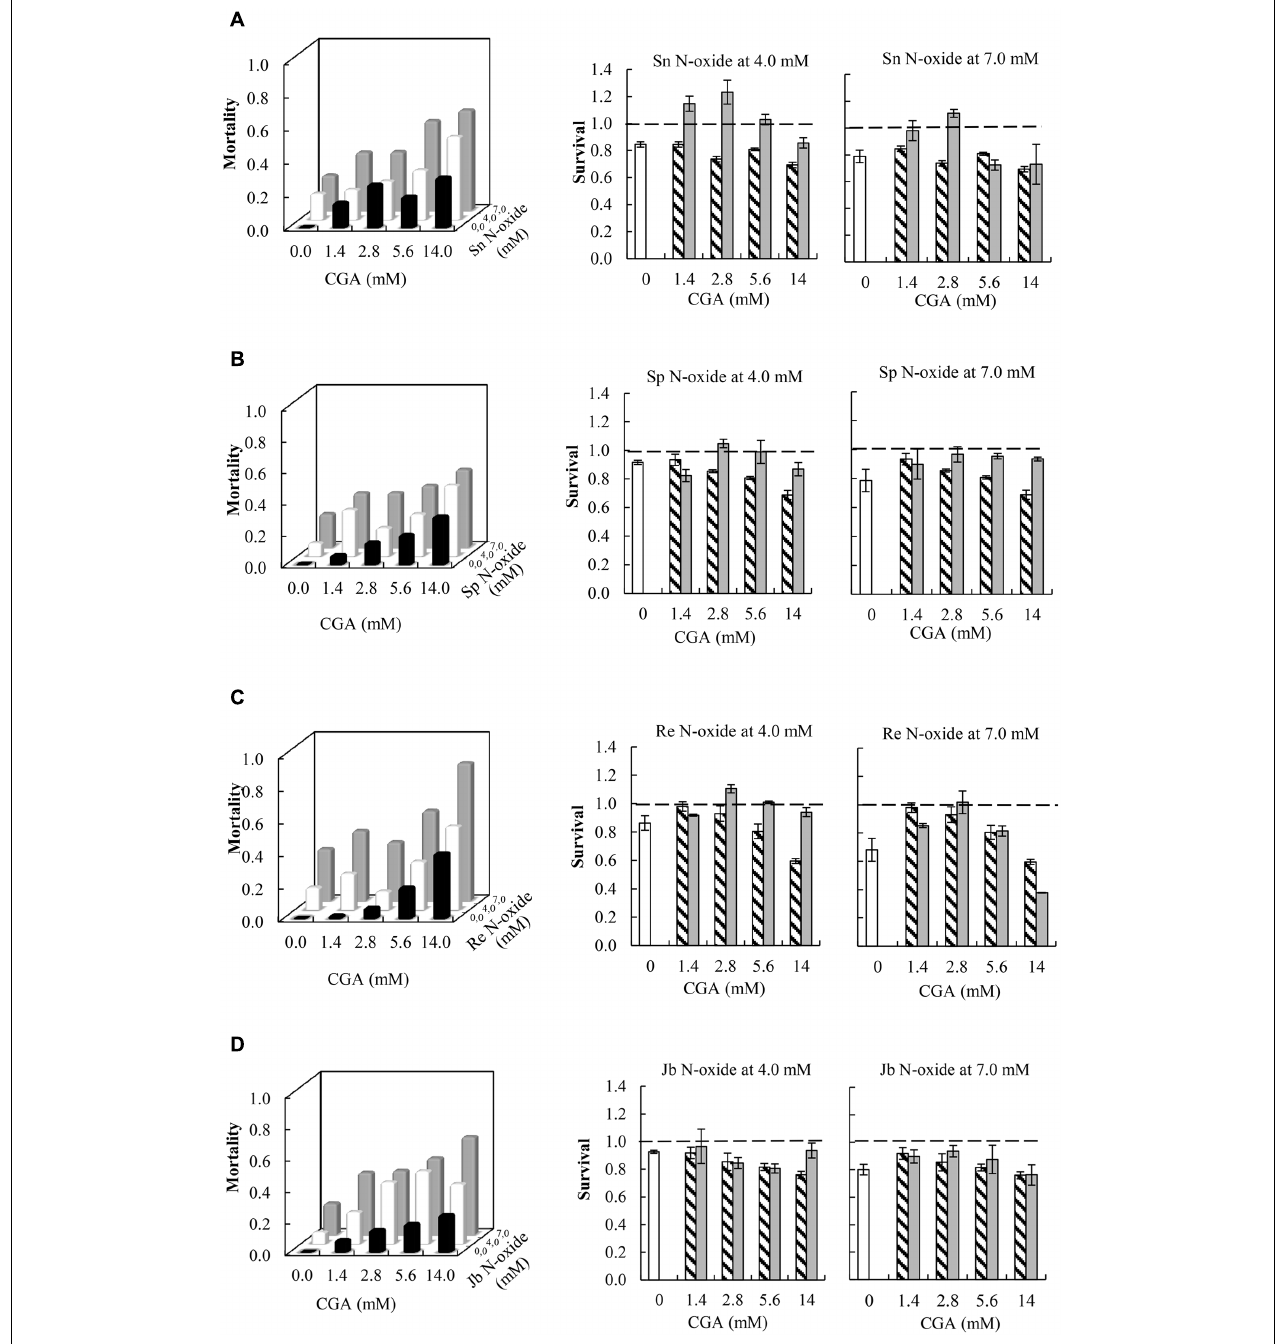
FIGURE 5 | Left: Fraction mortality (1- fraction survival) of 2nd instar thrips larvae ( F. occidentalis ) caused by single metabolites and the combination of CGA with senecionine N -oxide (A) , seneciphylline N -oxide (B) , retrorsine N -oxide (C) , and jacobine N -oxide (D) . Right: Fraction survival (mean ± 95% confidence intervals) of thrips caused by PA N -oxides alone (white bars), CGA alone at four concentrations (hatched bars), and the interaction effect S X ∗ Y (Equation 4) between PA N -oxides and CGA (gray bars). In the left figures, the fraction mortality was plotted to increase the readability of the figure. In the right figures, the dashed line indicates a thrips survival fraction of one. A significant deviation from one indicates a synergistic ( < 1) or antagonistic effect ( > 1). Two-way ANOVAs were used to analyze whether the overall interaction effect S X ∗ Y deviated significantly from one ( Table 3 ). Sn N -oxide, senecionine N -oxide; Sp N -oxide, seneciphylline; Re N -oxide, retrorsine N -oxide; Jb N -oxide, jacobine N -oxide.